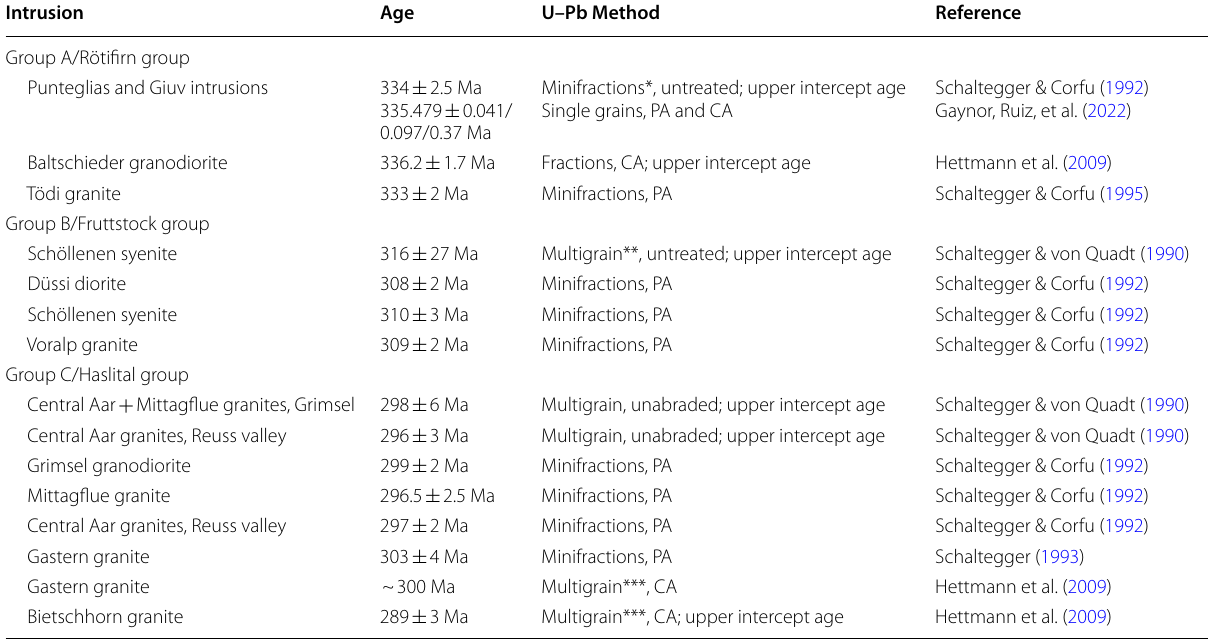
Table 2 Compilation of previous U–Pb